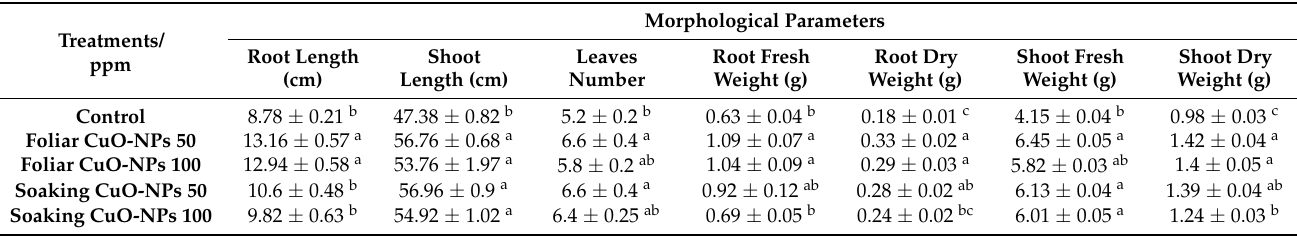
Different letters in the same column indicate that mean values are significantly different ( p ≤ 0.05) by Tukey’s test, means ± standard error (SE) ( n =